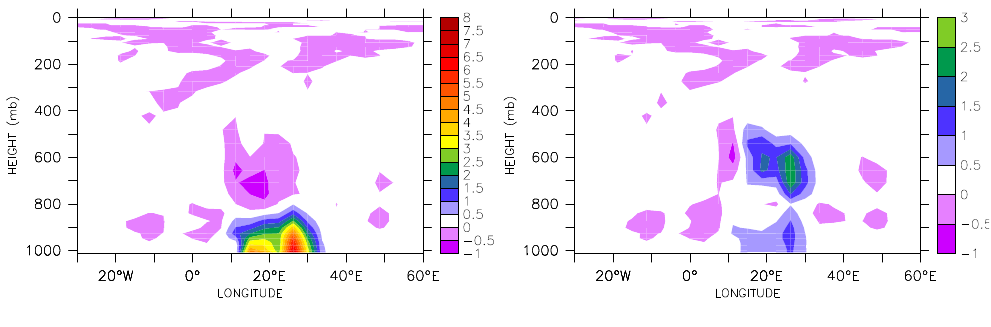
Fig. 11. Vertical section of the amplitude of the diurnal cycle of CO 2 (ppmv) averaged between 5S and 20S over the 20 last days of July for simulation REF (left) and TH (right).